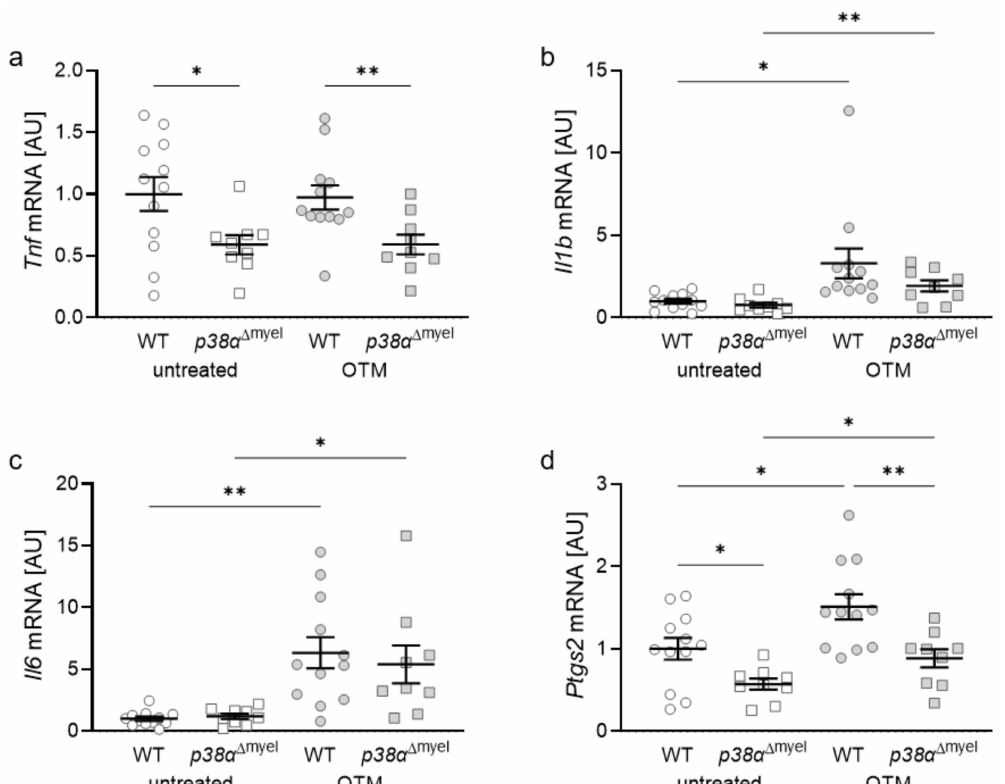
Figure 3. Expression of the inflammatory genes tumor necrosis factor ( Tnf, ( a )), interleukin-1b ( Il1b , ( b )), interleukin-6 ( Il6 , ( c )) and prostaglandin endoperoxide synthase-2 ( Ptgs2 , ( d )) at the orthodontically treated (OTM) and untreated jaw side of wildtype (WT; n = 12) and mice without p38 α /MAPK in myeloid cells ( p38 α ∆ myel mice; n = 9). Each symbol respresents one data point. The horizontal line represents the mean value and the vertical lines represent the standard error. Statistics: ANOVA test followed by unpaired t -test with Welch’s correction, * p < 0.05; ** p <